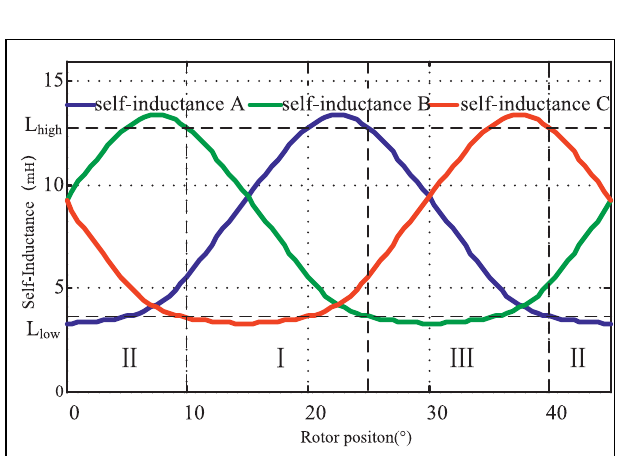
FIGURE 6 | Schematic diagram of three-phase self-inductance partitions.